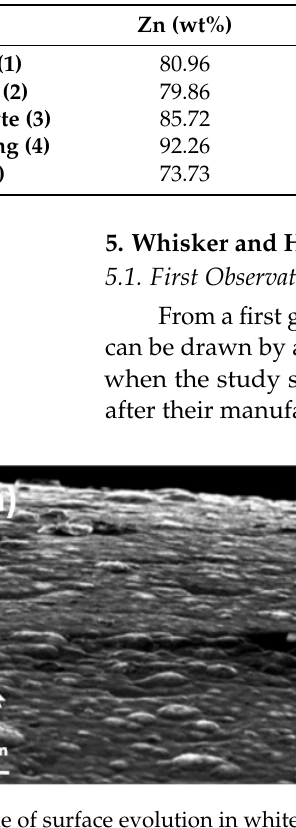
Table 4. Chemical composition of the coatings.